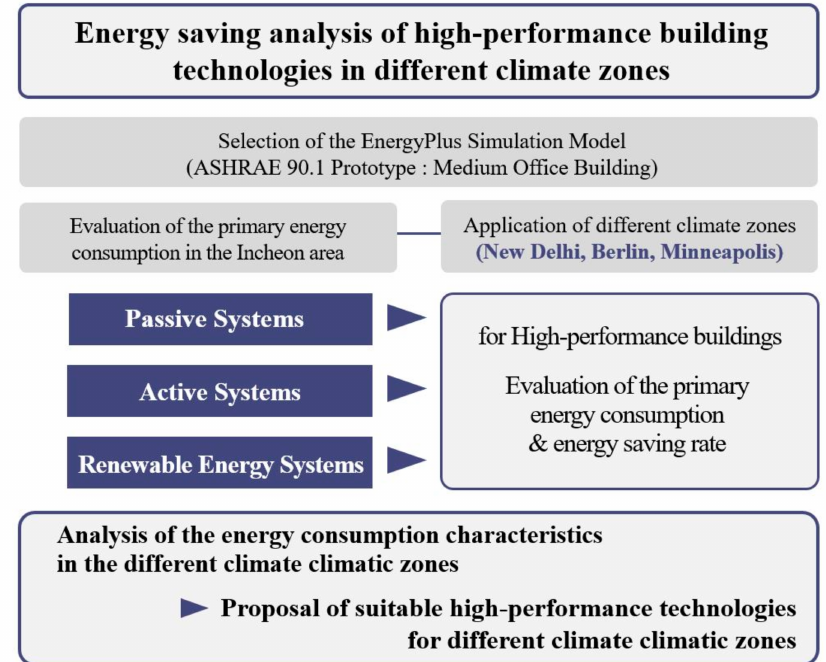
Figure 1. Flowchart of this